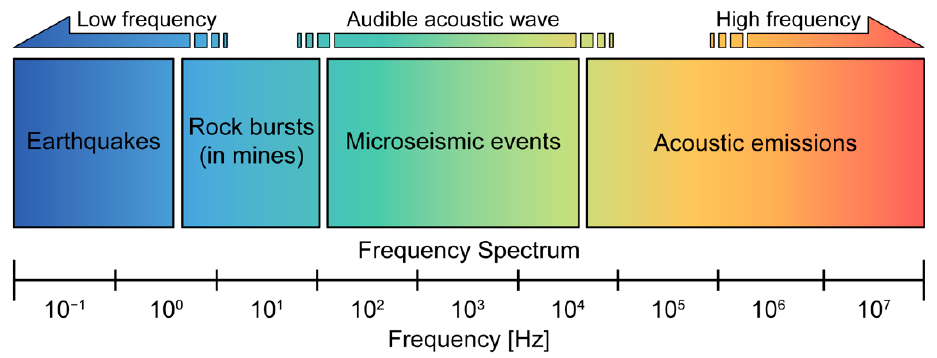
Figure 1. Seismic motion wave frequency spectrum and field of application of MS monitoring.